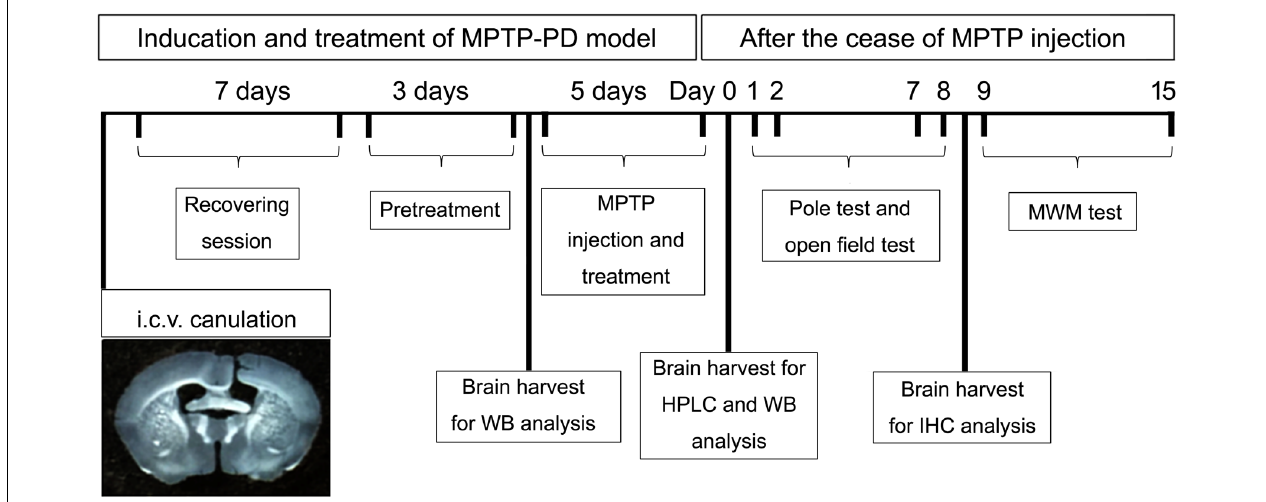
FIGURE 1 | A schematic diagram depicted the experimental design in the present study. Schematic timeline representation for cannula placements of i.c.v. injections, recovery, pretreatment and administration of drugs or vehicles, pole test, open field test, and Morris water maze test. HPLC, high performance liquid chromatography; WB, western blot; MWM, Morris water maze; IHC,